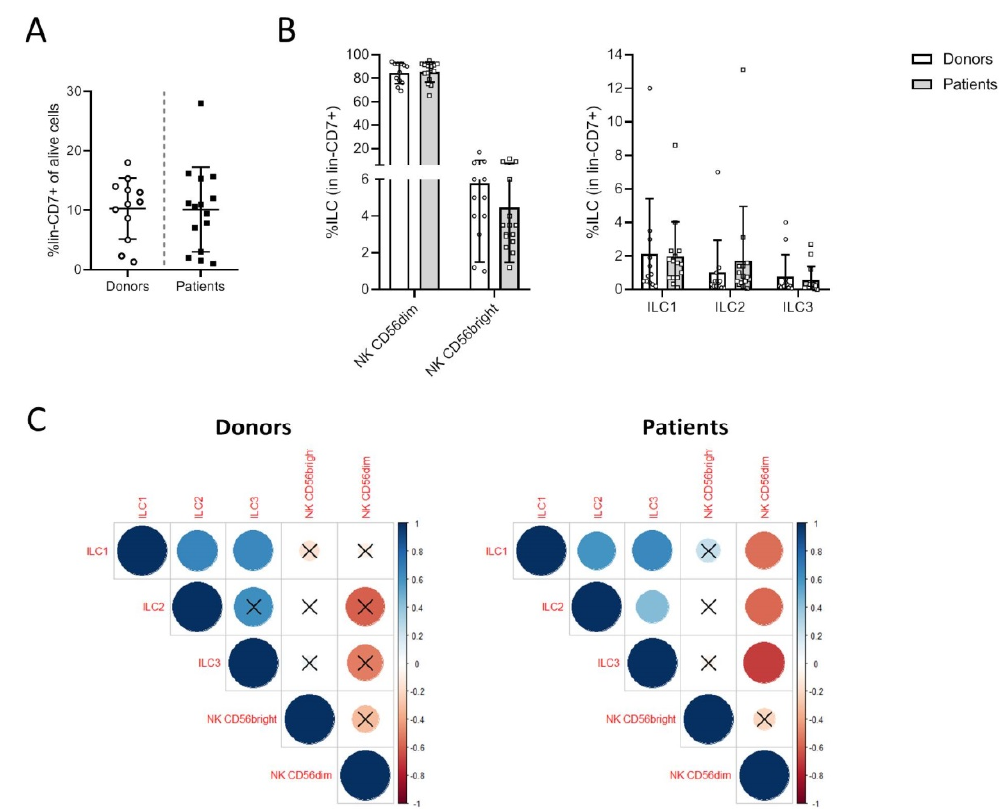
Figure 1. Proportions of innate lymphoid cell (ILC) subsets among the global lin-CD7+ population. Percentages of lin − CD7 + ILCs in live peripheral blood mononuclear cell (PBMC) from donors and patients ( A ). Percentages of the different ILC populations in lin − CD7 + cells ( B ). Correlations between the proportions of ILC populations in lin − CD7 + cells. A Spearman test was used to calculate the correlation coefficient (X: p value > 0.05) ( C ).